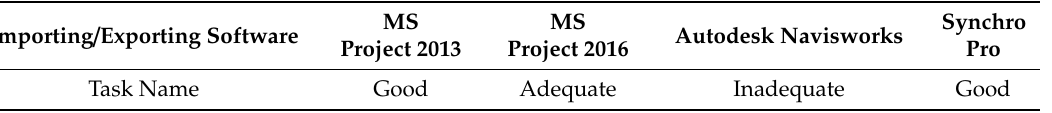
Table 9. Summary of the results of the assessment of BIM software packages tested for interoperability through the exchange of Gantt